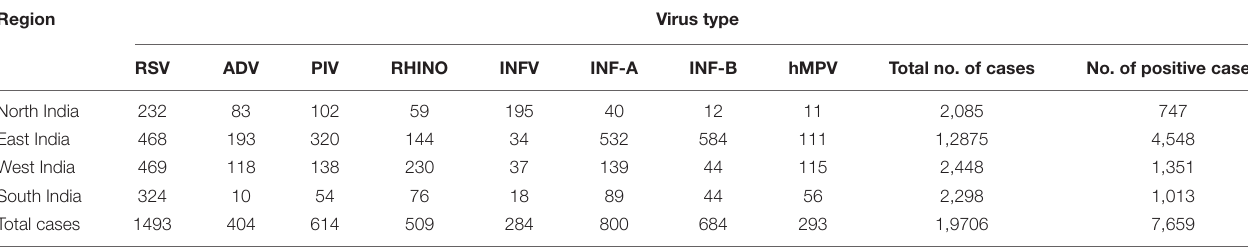
TABLE 2 | Prevalence of virus infections based on the geographical regions in India (1970–2020). Region